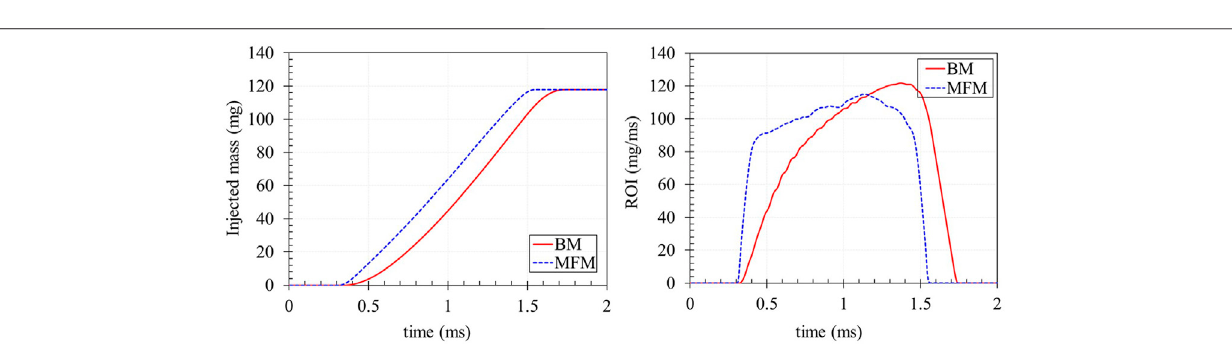
FIGURE 5 | Average Rate of Injection from BM and MFM at 1500 bar injection pressure and a DOI of 1 ms.